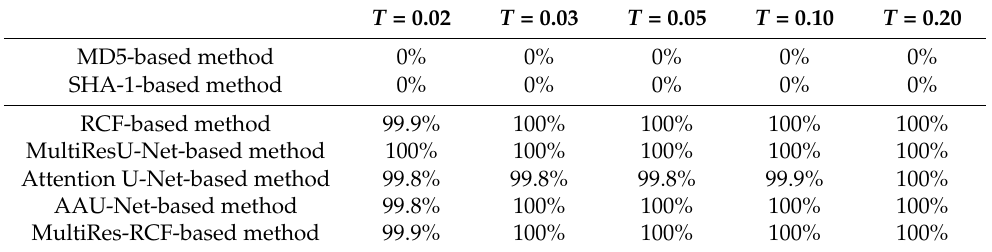
Table 6. Robustness test comparison of watermark embedding (32 bits embedded in single band). T =